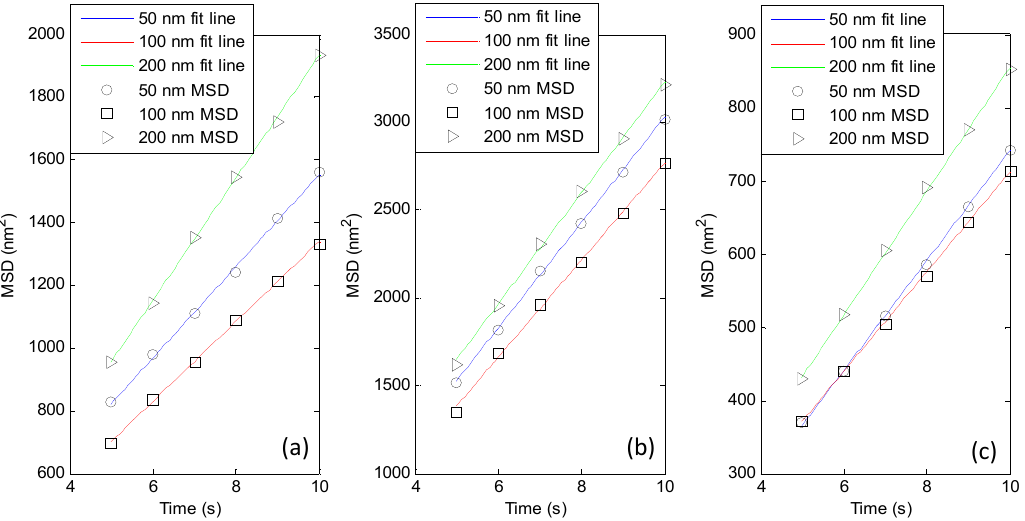
Figure 11. Relationships between each case of mean square displacement (MSD) and its corresponding diffusion constant D , for ( a ) M1, ( b ) M2, and ( c ) M3.